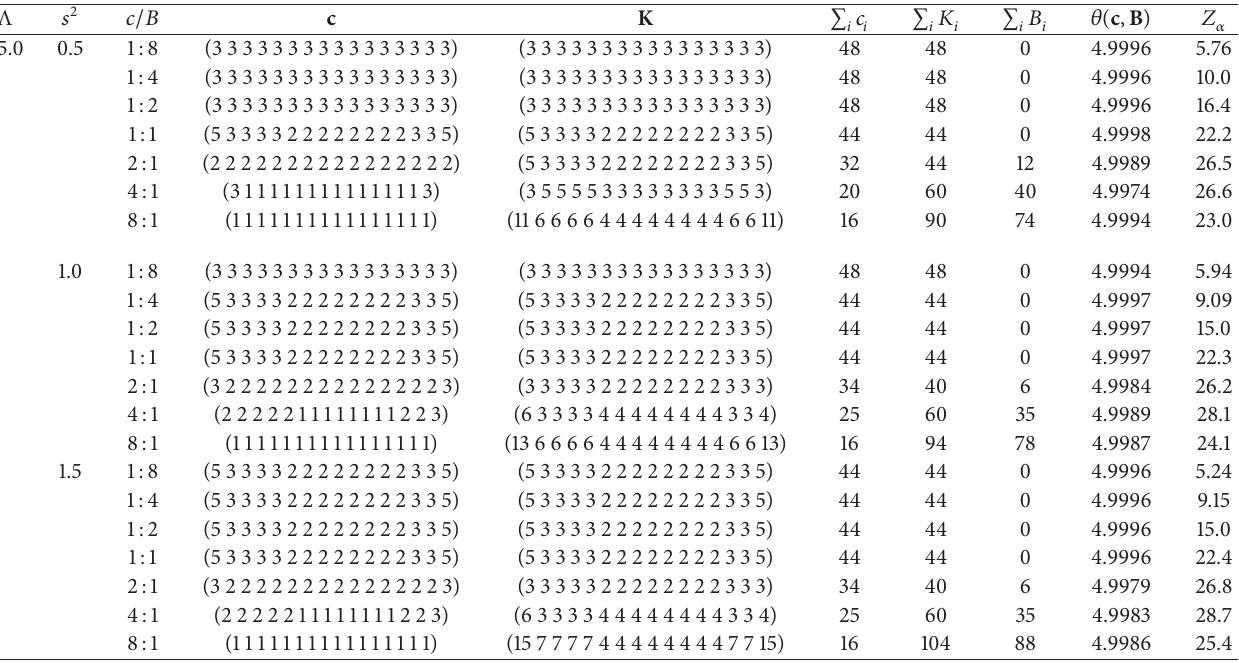
Table 3: Results for the joint buffer-server allocation